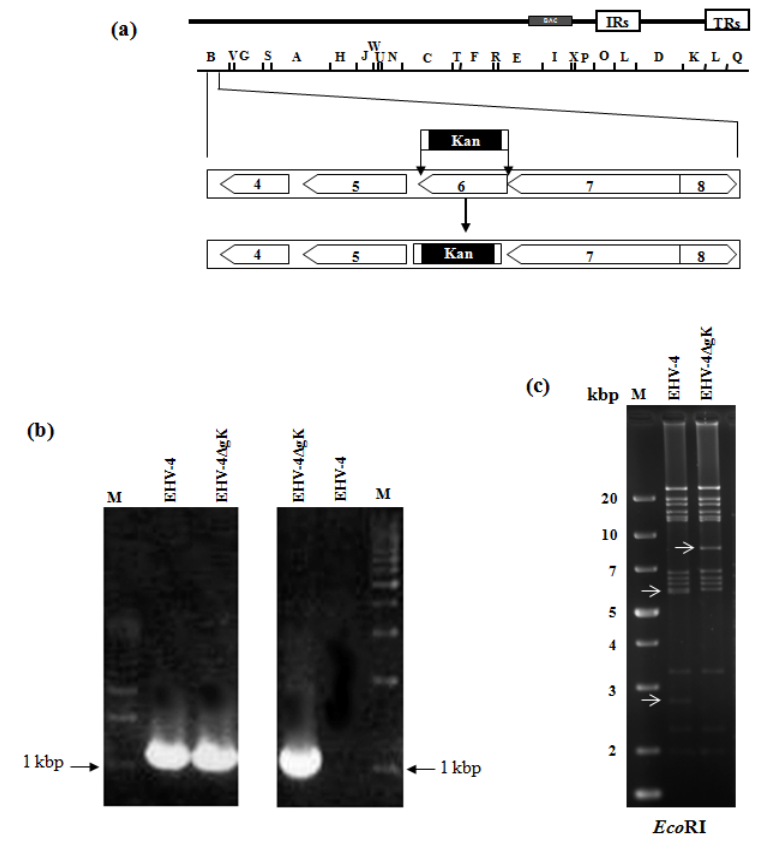
Figure 1. Mutagenesis and generation of gK deleted mutant. (a) Schematic diagram of the procedures used to delete the gK gene from EHV-4 BAC. Schematic representation of the genomic organization and the Bam HI restriction map of EHV-4 BAC pYO03 [11] is given. The genomic organization of the domain that encodes the genes from 4 to 8 [16] is depicted within the Bam HI B restriction fragment. The PCR cassette conferring Kan R gene was inserted into the gK locus of pYO03 using Red recombination. (b,c) Identification of EHV- 4∆gK by a combined PCR/RFLP analysis. PCR products from parental EHV-4 and mutant virus were electrophoresed in a 1 % agarose gel. Primers binding to the outside of the deleted gK (left panel) as well as one sense primer that binds to the Kan R gene and another anti-sense primer that binds to the outside of gK (right panel) were used. A molecular weight marker (lane M) was included (b). Purified DNAs from EHV-4 and EHV- 4ΔgK were digested with Eco RI (c). Fragments in the mutants that appeared or disappeared as a consequence of the insertion of Kan R gene instead of gK are marked by